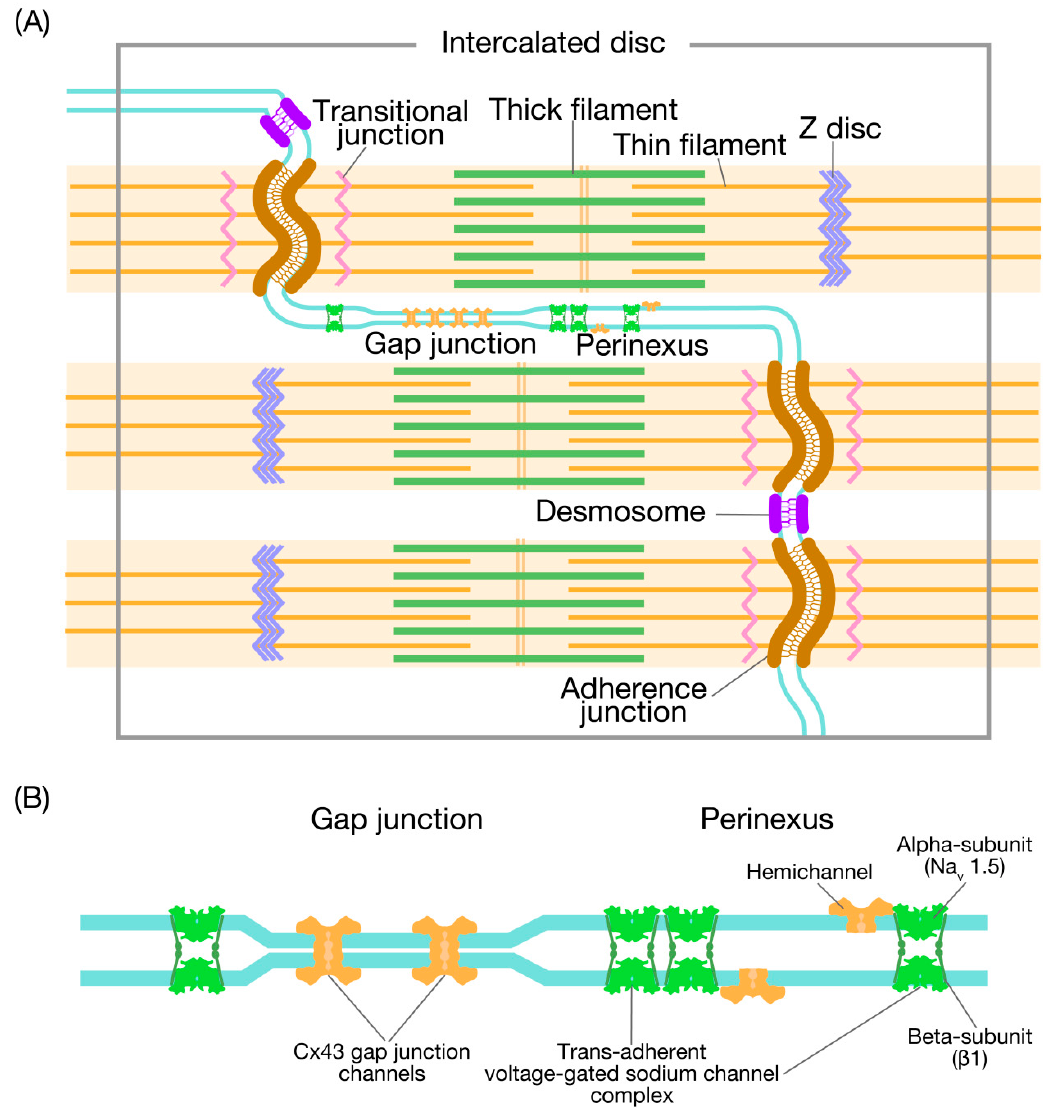
Figure 1. Illustration showing the domains associated with the intercalated disc. ( A ) The intercalated disc (ID) between cells predominantly accommodates three types of intercellular junctions: the adherens junction, the desmosome, and the gap junction (GJ). Thin filaments from the last sarcomere of the myofibrils insert in the adherens junction passing through a transitional junction (TrJ), which is rich in Z disc proteins (hence, an immature Z disc). At the edge of the GJ, there is an extracellular nanodomain, i.e., the perinexus (see ( B ) for details). See [6]. ( B ) Illustration showing the GJ and adjacent perinexus. The GJ comprises a cluster of Cx43 channels, docking within the narrow 2-nm gap. While the α -domain of Na v 1.5 has a relatively scarce presence in the GJ, the sodium channels are enriched in the perinexus. In this case, the non-pore-forming β -subunit of Na v 1.5 cross-links the two sides of the perinexus. Undocked Cx43 hemichannels are also expressed in the perinexus. See [8].